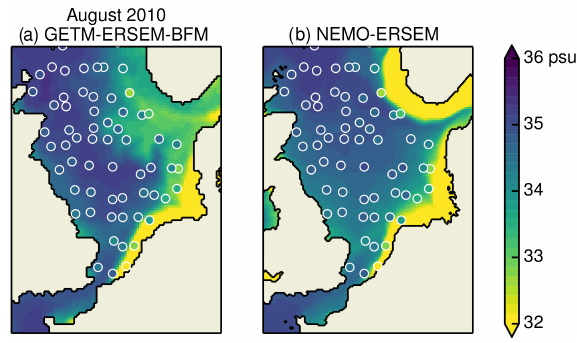
Figure 6. Maps of monthly mean SSS for August 2010 from (a) GETM-ERSEM-BFM and (b) NEMO-ERSEM. The in situ IBTS observations from August 2010 are overlaid in